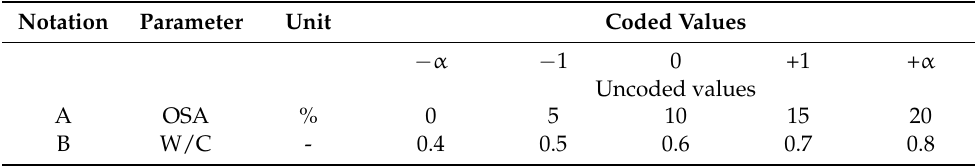
Table 1. Factors in uncoded values for the coded values of different parameters.